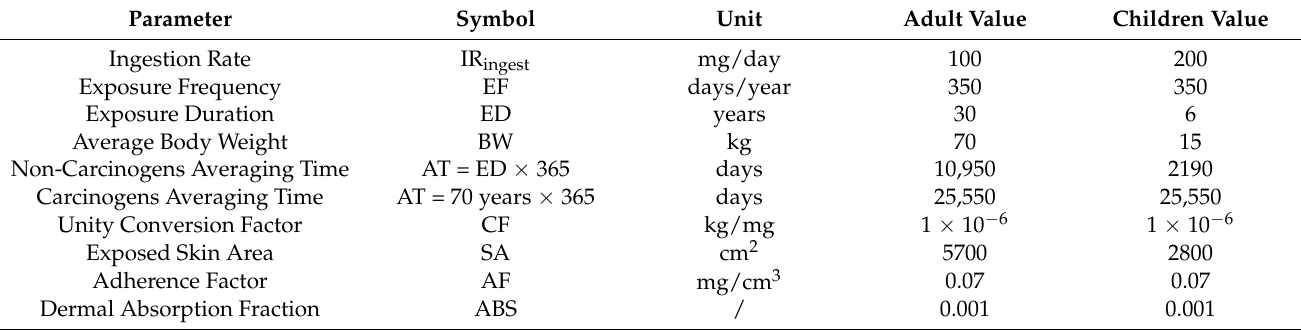
Table 1. Parameter values used to compute average daily dose by ingestion and dermal contact